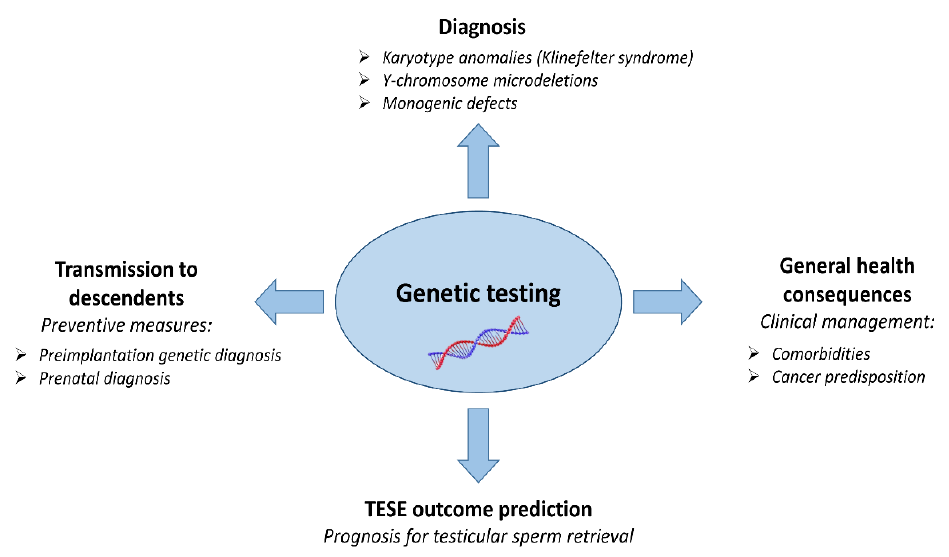
Figure 1. Clinical relevance of genetic testing in azoospermic